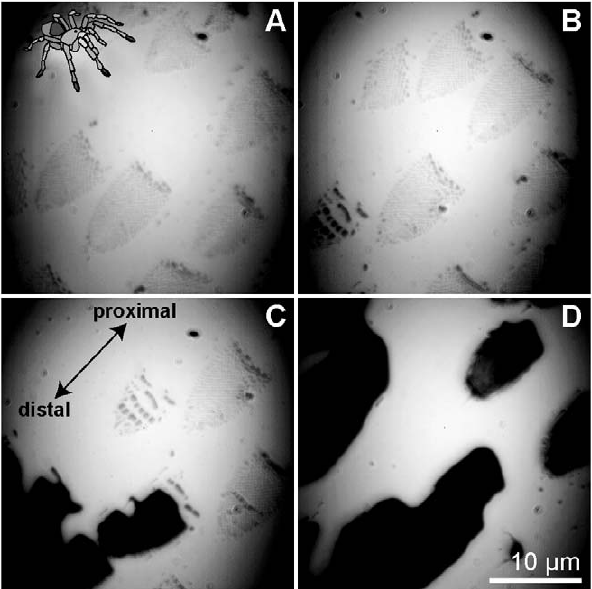
Figure 2. Interference reflection microscopy of footprint secretions. (A) Persistent, hydrophobic tarsal fluid from the tarantula ( Grammostola rosea ) after aggregation of footprint for analysis, as viewed under green light (546 nm). (B) Volatile, hydrophilic droplets trapped under the foot of a mite ( Gromphadorholaelaps schaeferi ) appear lighter than the surrounding pad.